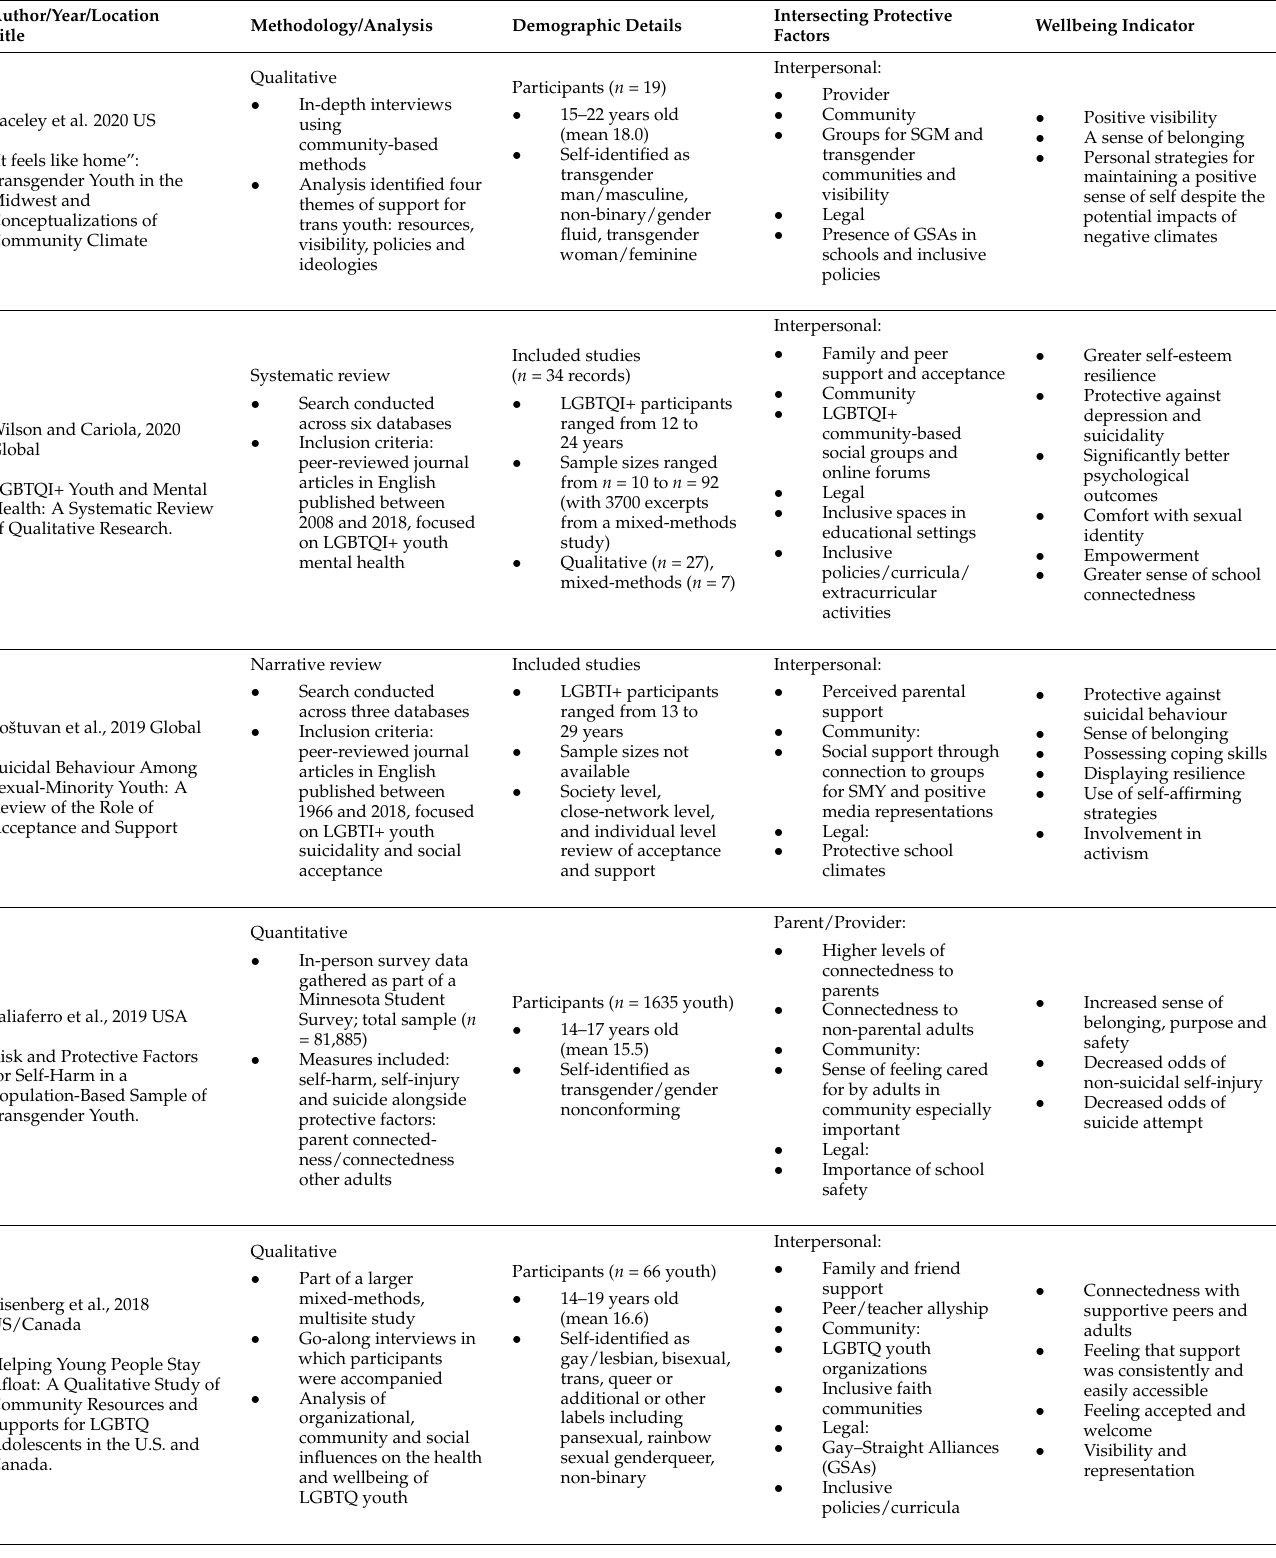
Table 7. Intersecting interpersonal, community and legal relations and protective factors for LGBTI+ youth wellbeing ( n = 19